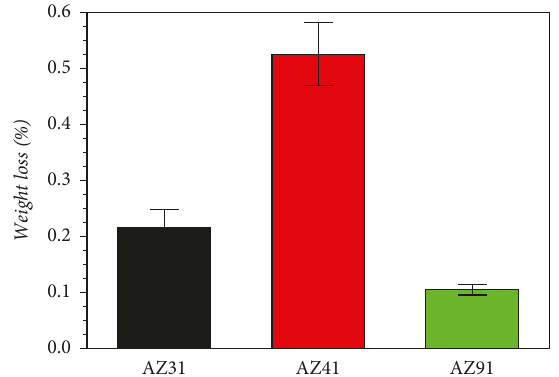
Figure 2: Color of the control and experimental groups in the f - test. As corrosion continues to occur, the color of the experimental group gradually changes: light salmon (OD 0.05), olive (cid:29) (OD 1.10), olive drab (OD 1.80). (cid:29) (cid:29)